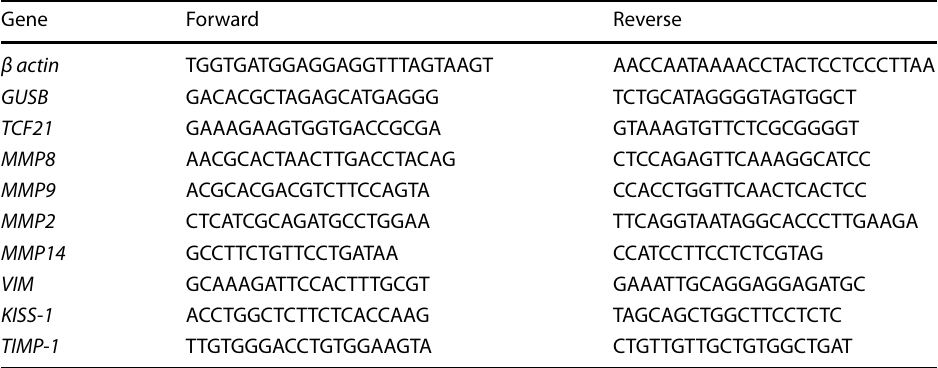
Table 1 Sequence of primers used in the qRT-PCR